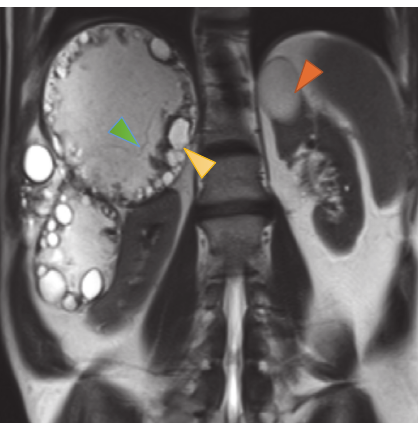
Figure 3: Coronal T2-weighted MR image shows multiple abdominal hyperintense lesions with smaller peripheral cysts compatible with daughter cysts (yellow arrow) and also thin linear septation, compatible with the detachment of the laminated membrane of the pericyst (green arrowhead). Note also a simple renal cyst (orange arrowhead), probably an incidental finding.